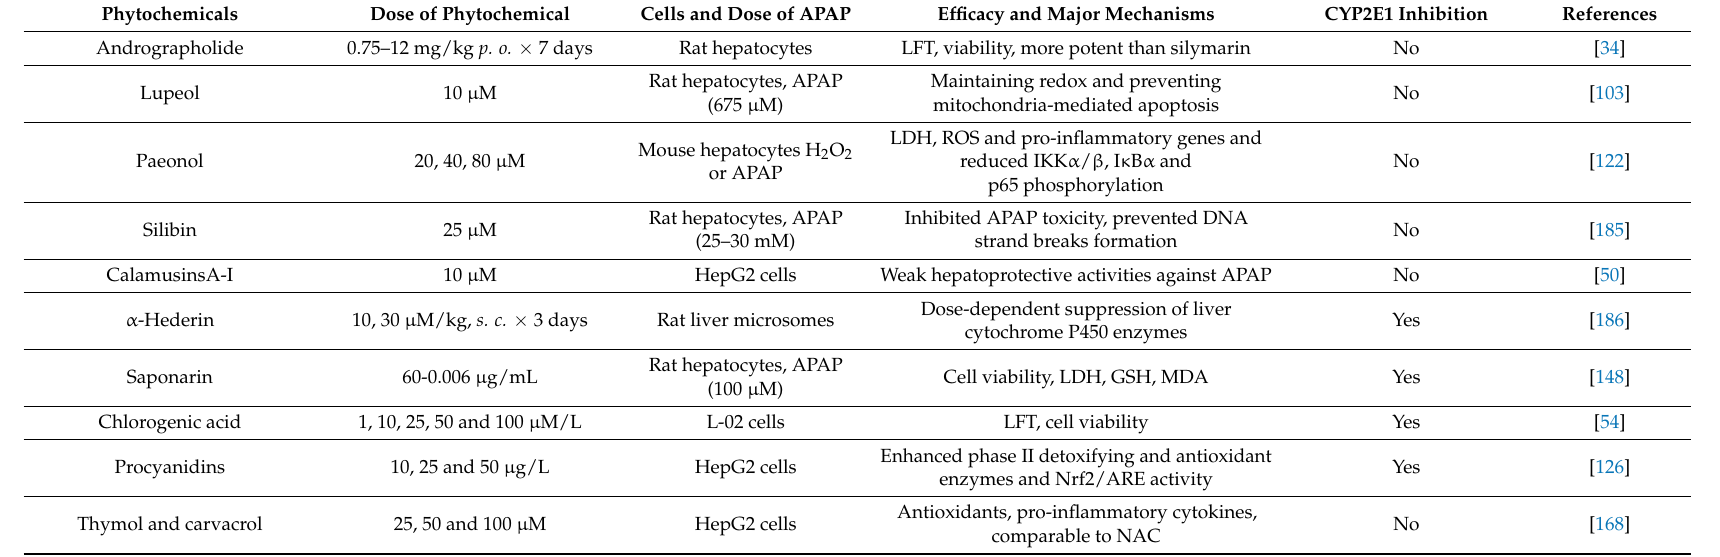
Table 3. Phytochemicals showed hepatoprotective effect in the in vitro model of acetaminophen-induced liver injury.